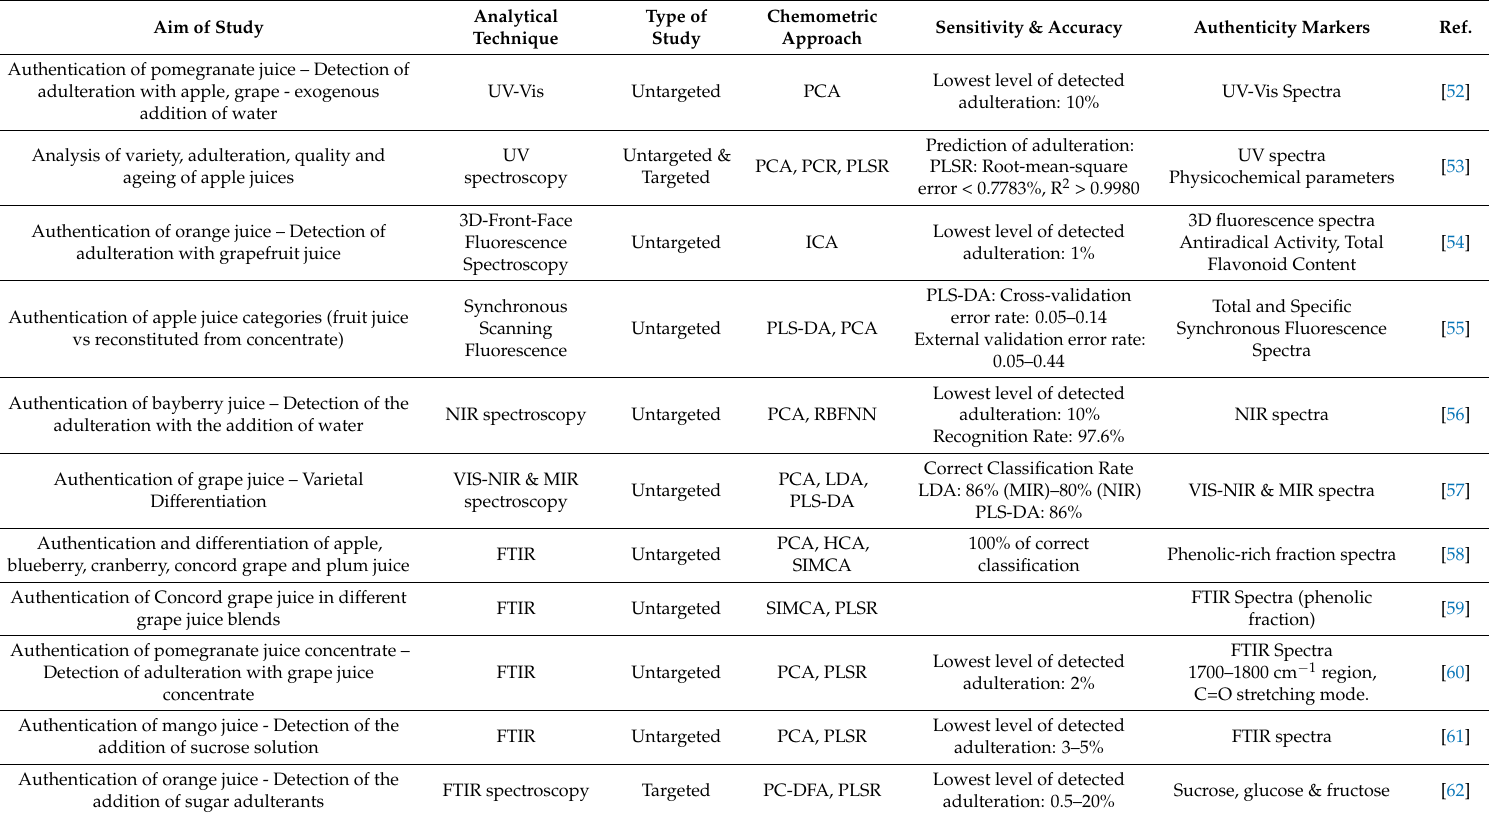
Table 3. Applications of spectroscopic techniques in authenticity studies of fruit